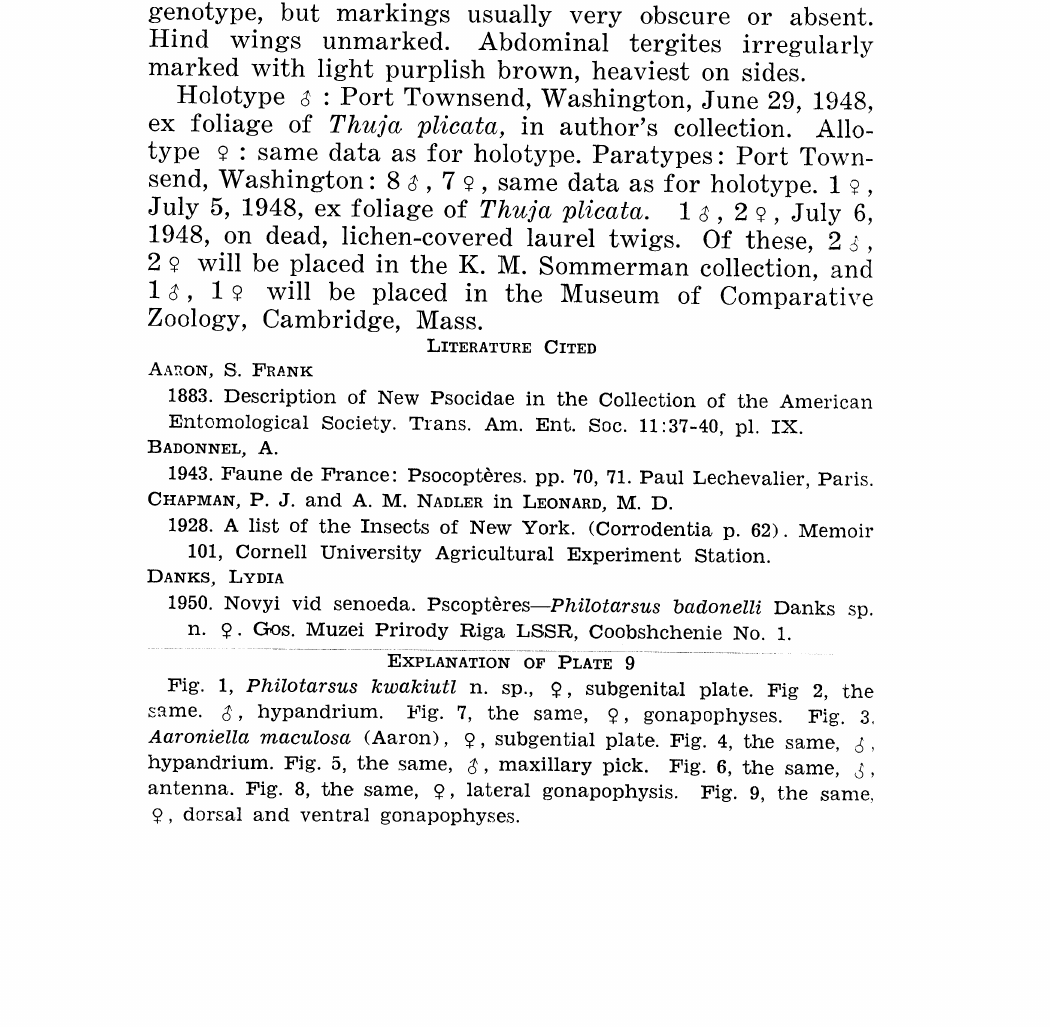
Aaroniella maculosa (Aaron), 9, subgential plate. Fig. 4, the same, hypandrium. Fig. 5, the same, 3, maxillary pick. Fig. 6, the same, antenna. Fig. 8, he same, 9, lateral gonapophysis. Fig. 9, the same, 9, dorsal and ventral